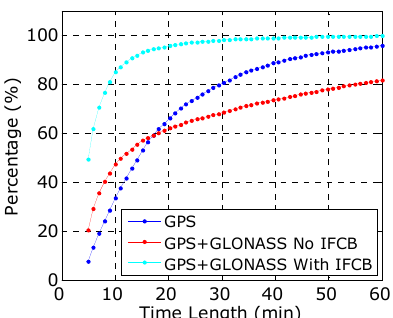
Figure 14. Fixing percentage for various observation durations for kinematic PPP with different strategies. Receivers with heterogeneous types are used rover sites.